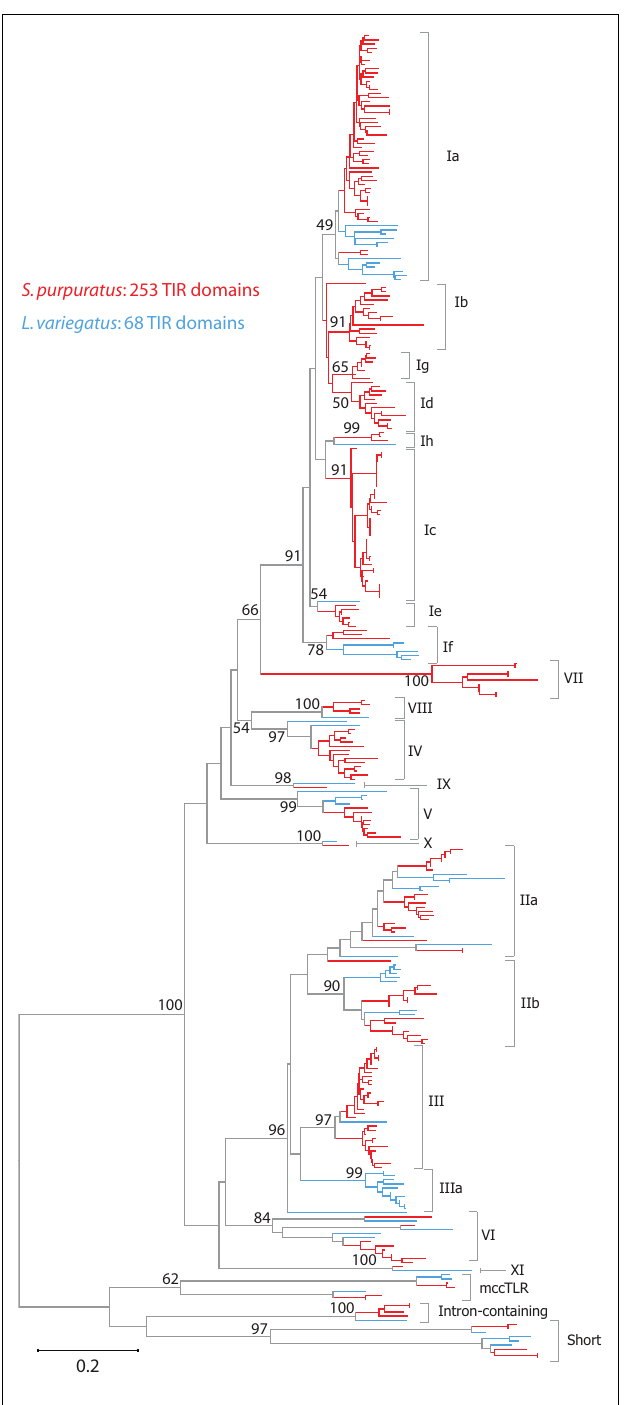
FIGURE 2 | Phylogeny of sea urchinTLR sequences. TheTIR domains from the S. purpuratus (red branches) and L. variegatus (blue branches) TLRs were used to construct a neighbor-joining tree in MEGA 5.0 (Tamura et al., 2011) using Poisson corrected distances. Alignment positions containing gaps were eliminated completely from the analysis. Bootstrap values are shown and are based on 1000 replicates. Each of these clades is also reconstructed using other methods (maximum likelihood and maximum parsimony; data not shown).The subfamily for each clade is designated on the right. A more detailed version of this tree is shown in FigureA1 in